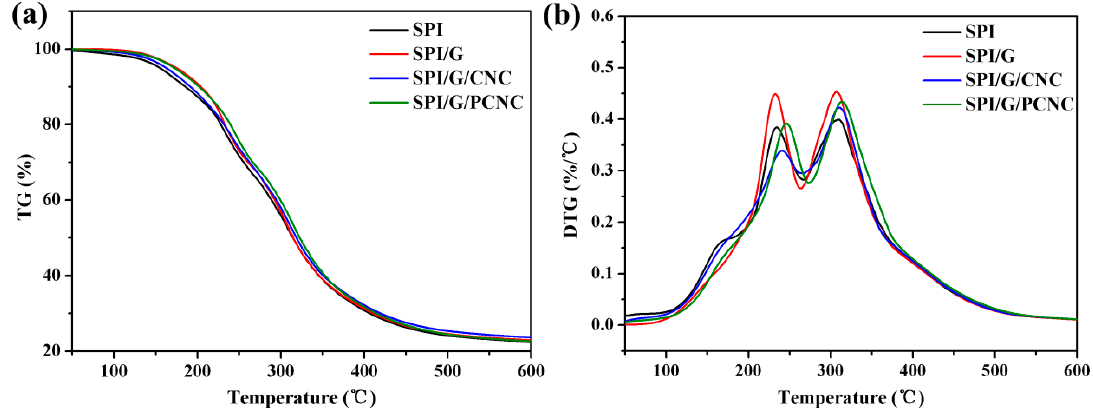
Figure 7. ( a ) Thermo gravimetric (TG) and ( b ) derivative thermo gravimetric (DTG) curves of SPI film and SPI-based films modified with graphene, CNC, and PCNC.